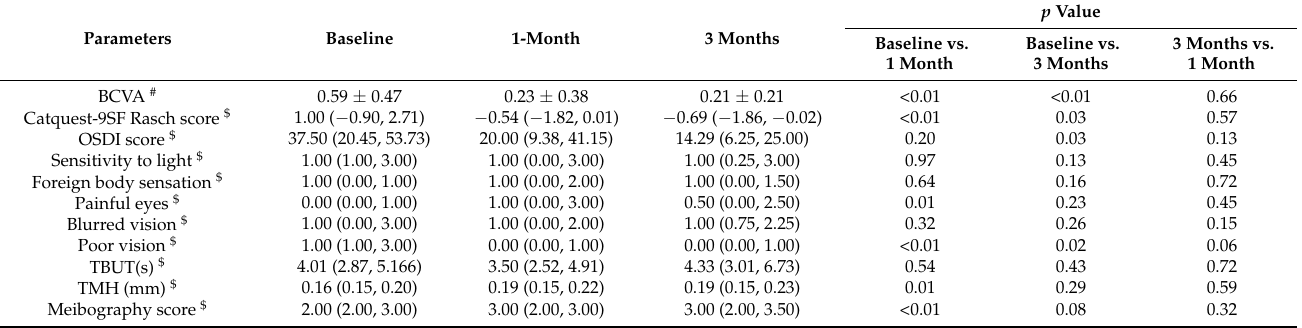
Table 1. Parameters of visual function, ocular symptoms and signs before and after cataract surgery.